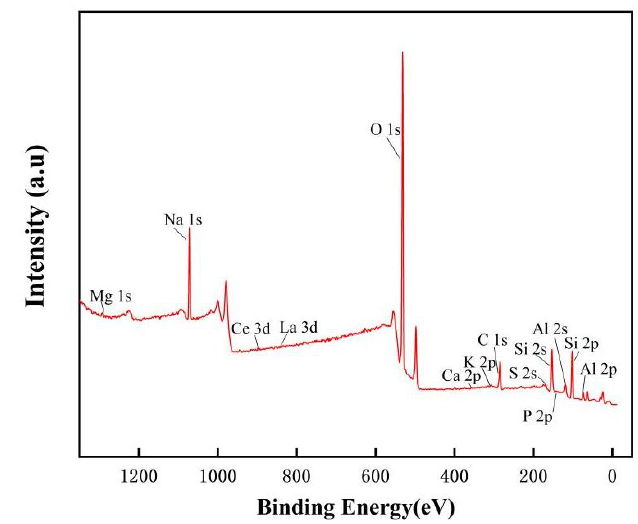
Figure 3. XPS of mullite whiskers after washing and drying.